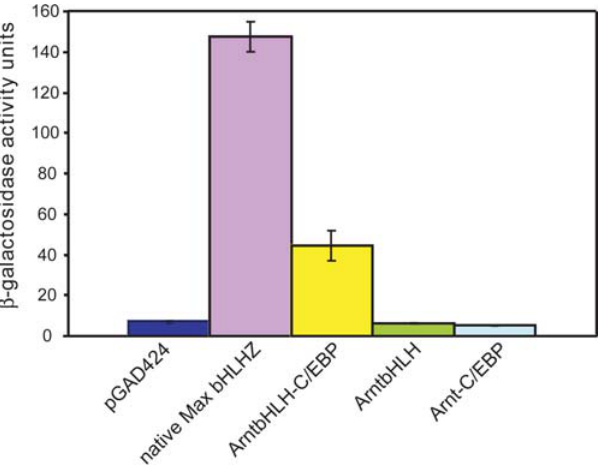
Figure 3. Histogram comparing ONPG assay data. All values are the averages of 9–12 individual measurements from 3–4 separate cell- growth cultures ( 6 SEM).